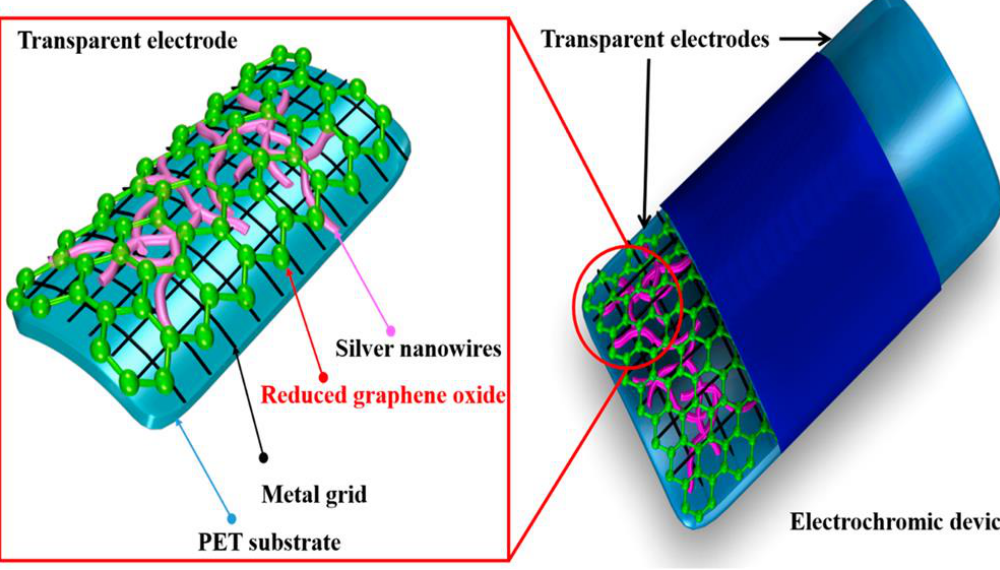
Figure 18. Schematic diagram of RGO / AgNWs / metal grid / polyethylene terephthalate (PET) electrode-based WO 3 electrochromic device (ECD)